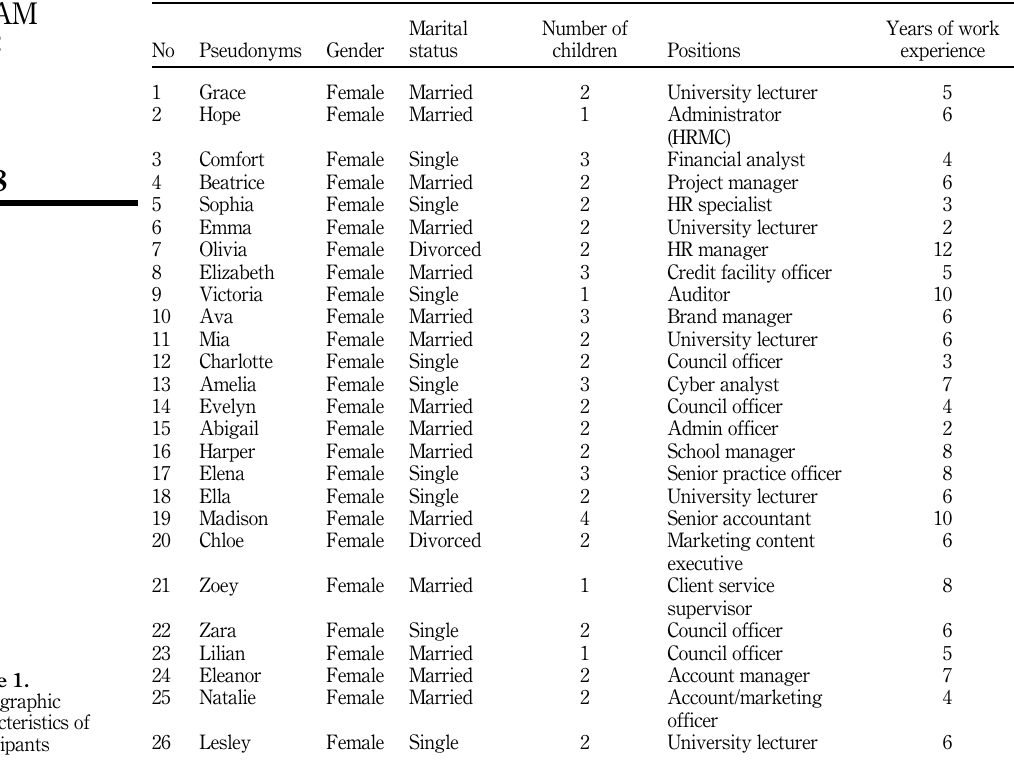
characteristics of